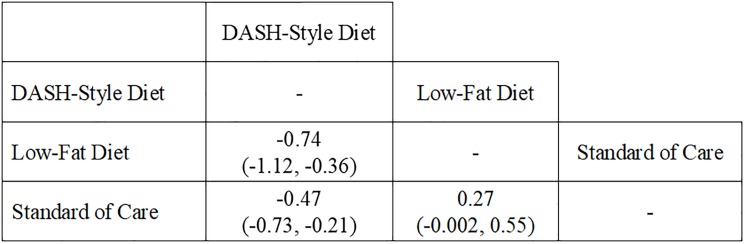
Effect of fasting glucose between diets in trials that did not provide gestational weight gain advice in both dietary arms.Abbreviations: DASH, Dietary Approach to Stop Hypertension. Fasting glucose is expressed in mmol/L. The value in each cell expresses the median difference (MeD) in fasting glucose with the 95% credible intervals (CrIs) in brackets between the diet in the column and the diet in the row (e.g. the MeD in fasting glucose between DASH-style diet compared to low-fat diet is -0.74 mmol/L (95% CrIs: -1.12, -0.36).